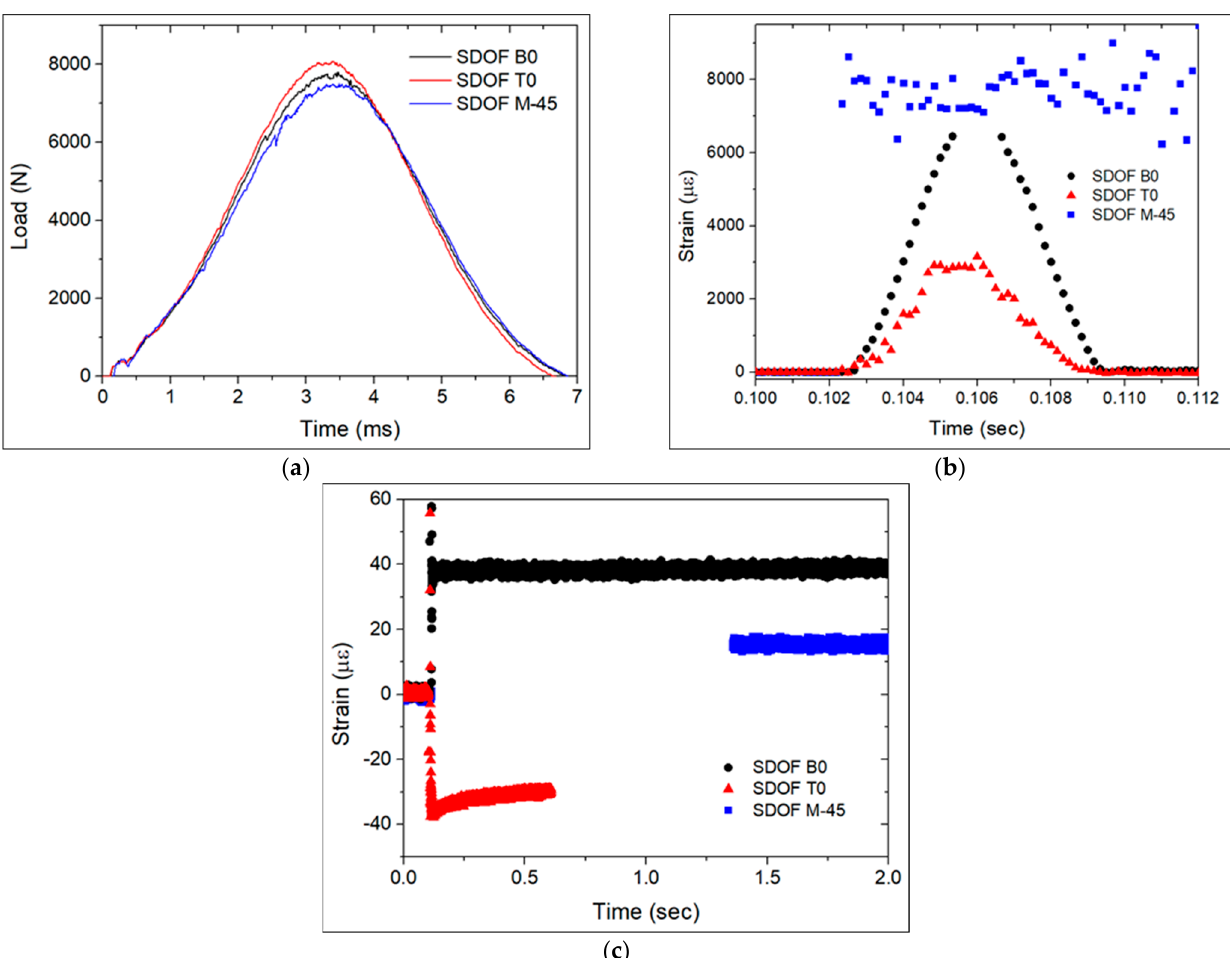
Figure 9. Second impact with an energy of 20.0 J on specimens with SDOF: ( a ) impactor load vs. time curves, ( b ) strain measured by the FBG S+T at the moment of impact, and ( c ) developed residual strains.